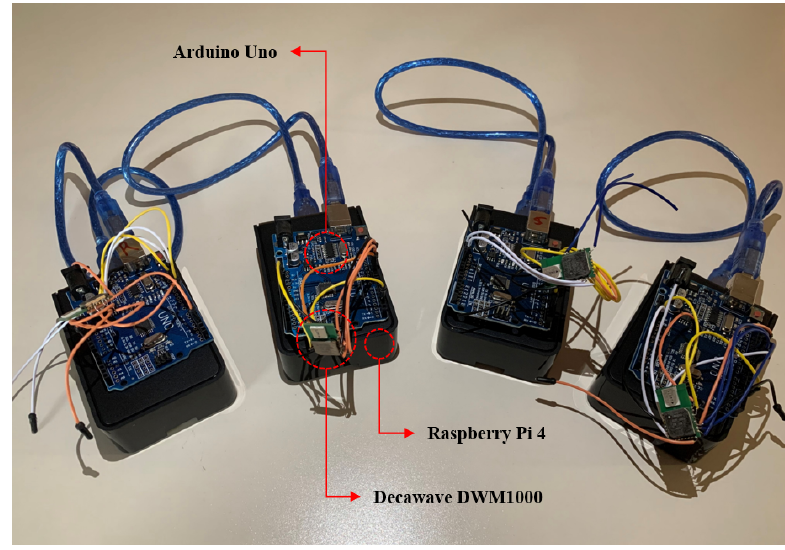
Figure 23. UWB sensor connected to Raspberry Pi 4 board.